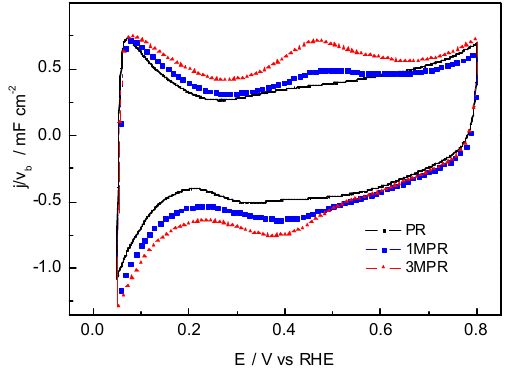
Figure 11. Blank voltammograms recorded at PR, 1MPR and 3MPR catalysts at 30 °C in 0.5 M H SO . Sweep rate = 0.02 V s − 1 . Reprinted with permission from Int. J. Hydrogen 2 4